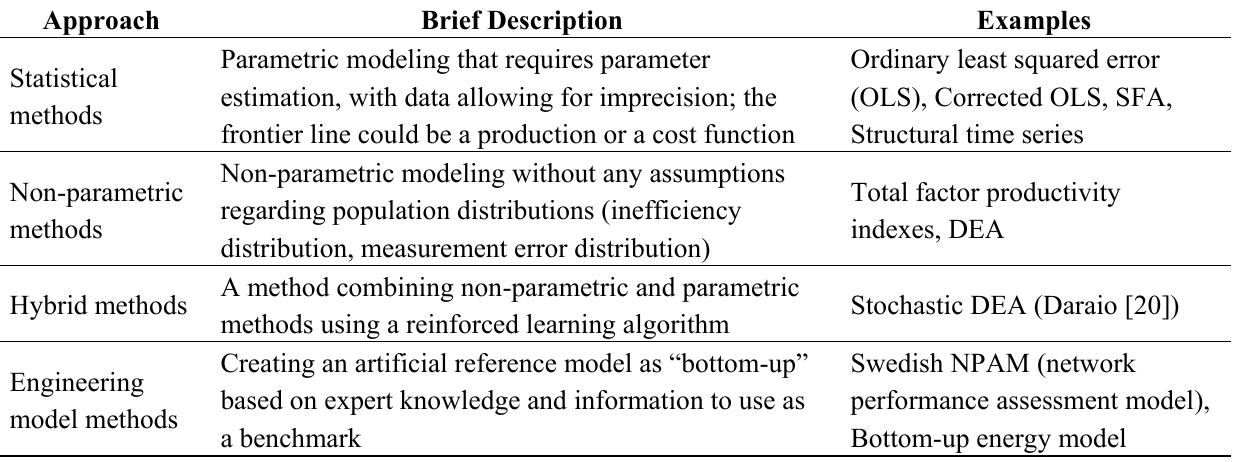
Table 2. Four benchmarking approaches (modified from